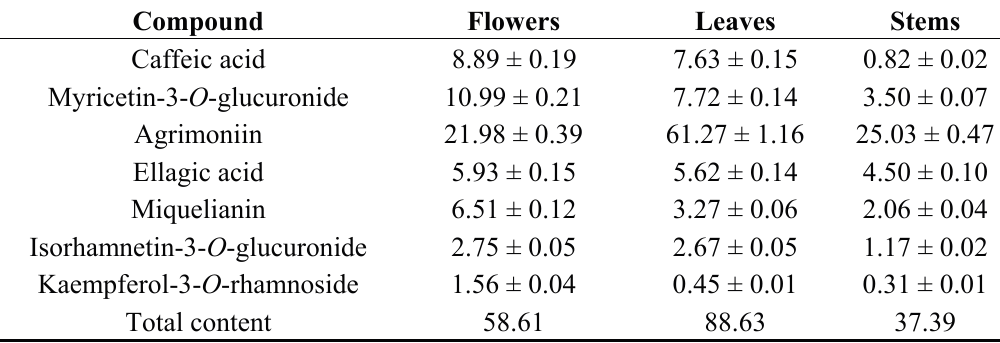
Table 7. Content of seven compounds in P. anserina organs, mg·g − 1 *.